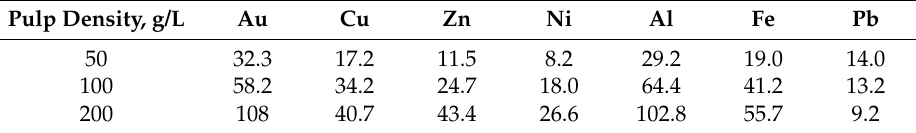
Table 3. Concentration of metals in the pregnant leach solutions after leaching, mg/L. Pulp Density, g/L